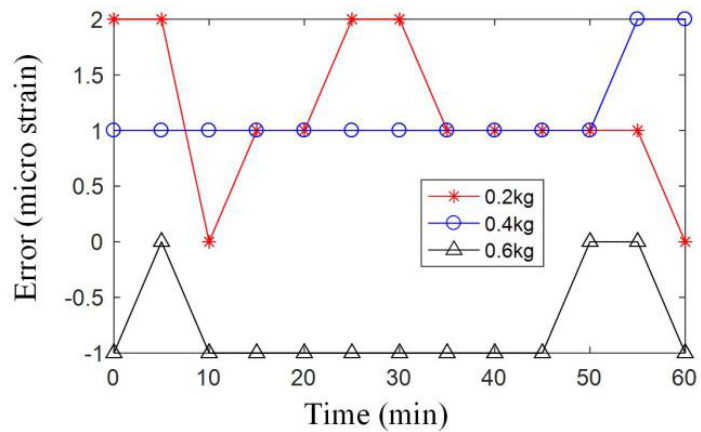
Figure 15. Errors between the measured strain and the theoretical results.